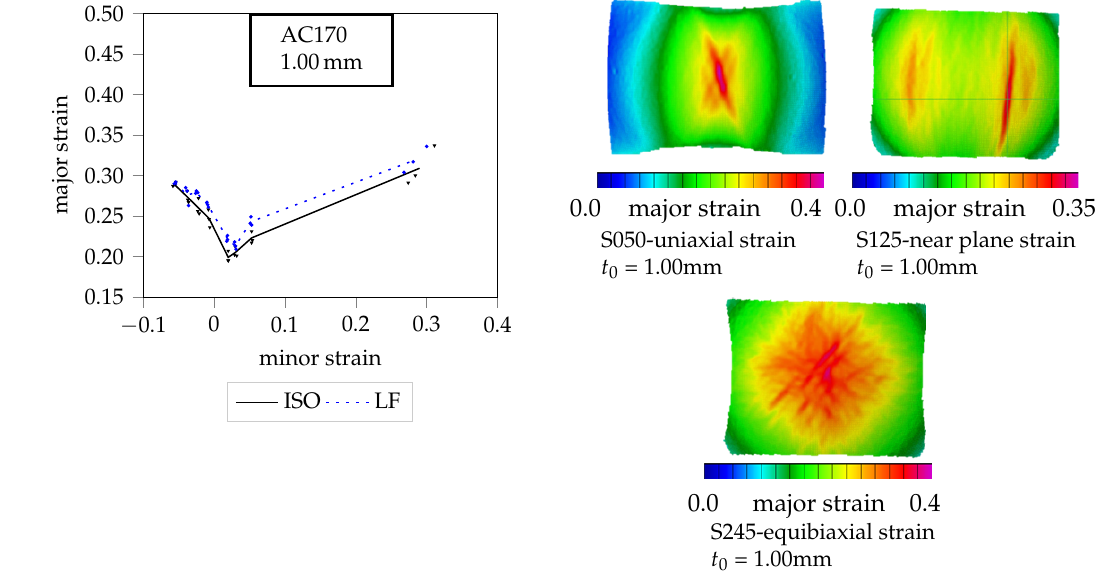
Figure 4. FLC of AC170 with Aramis visualizations of the strain distributions one step before